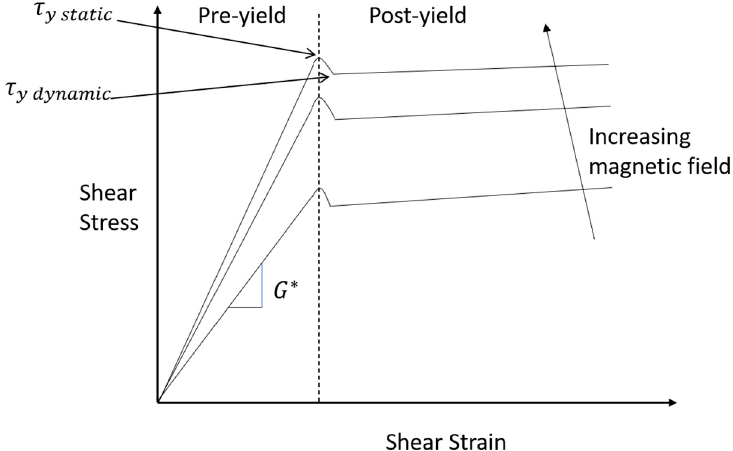
Figure 2. Shear stress–strain relationship of MR Figure 2. shear stress–strain relationship of MR material.